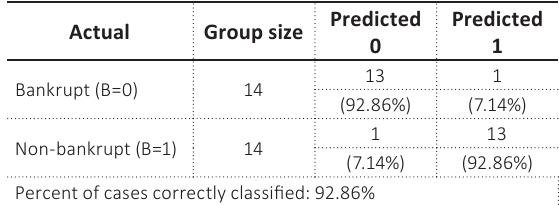
Table 11. Classification results ( t –2)